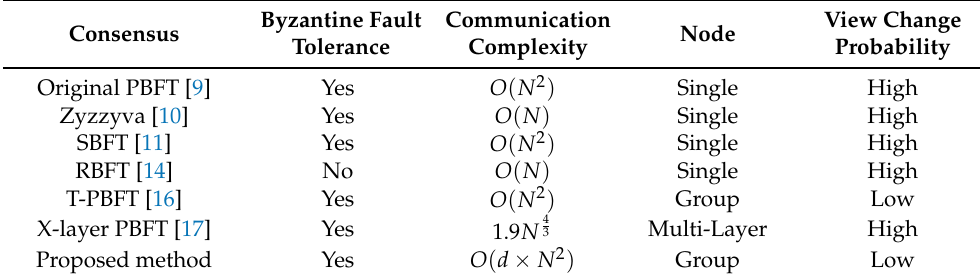
Table 6. Comparison results of the proposed method with other